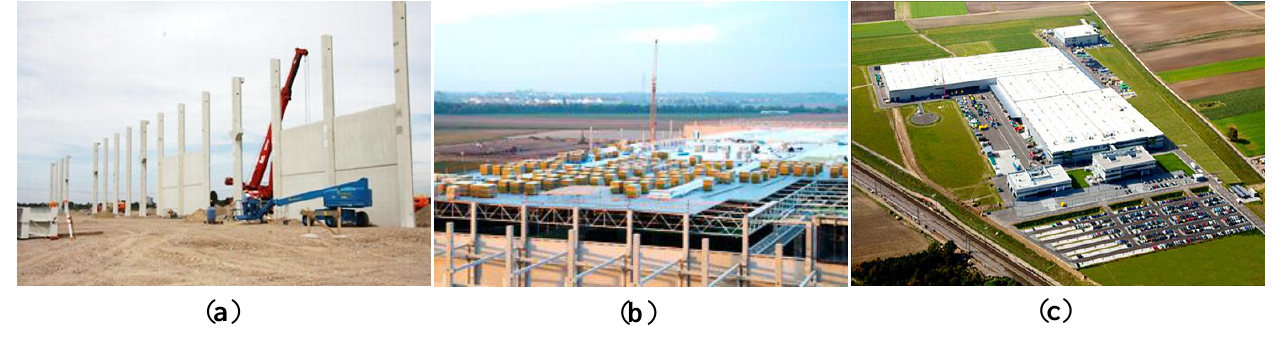
Figure 23. Terrestrial and aerial photos of the factory hall during construction and after completion published by the factory owner in his internet presence [34]. ( a ) Erecting columns. ( b ) Roof installation. ( c ) Completed factory